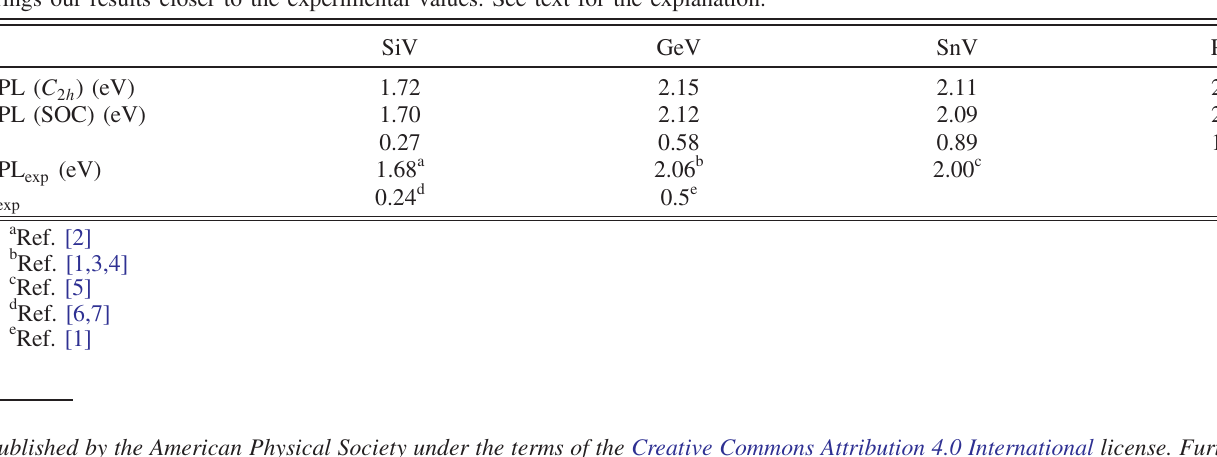
Þ ] and within the exact symmetry [ZPL ð C 2 h h